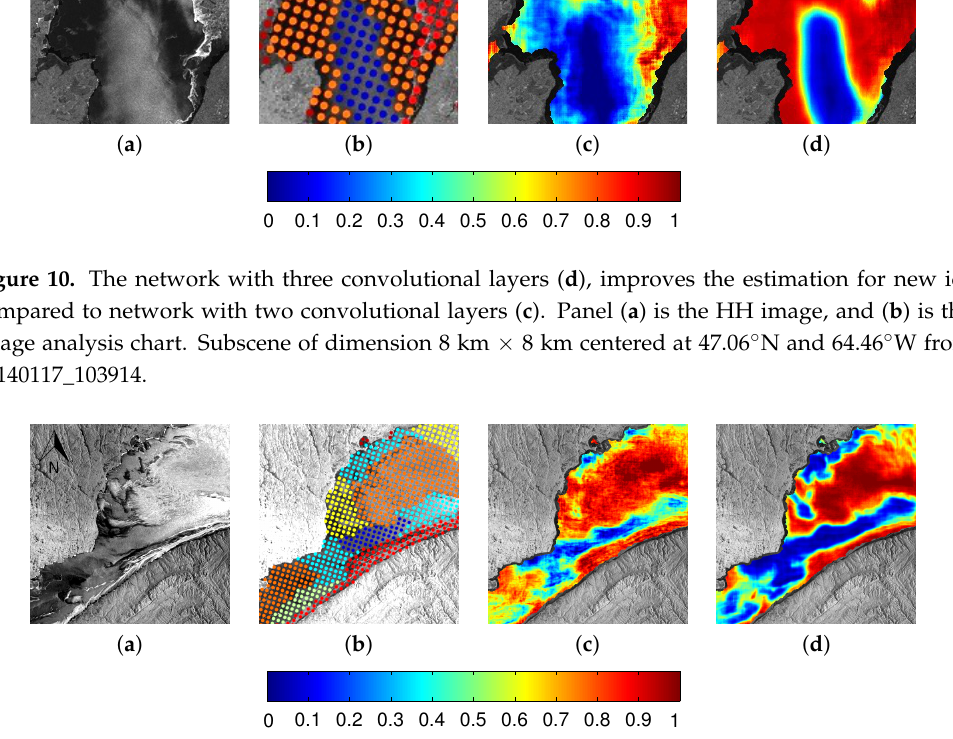
Figure 11. Comparison of results produced by networks with two-convolutional-layer ( c ) and three-convolutional-layer structures ( d ) for a sample location centered at 49.57 ◦ N, 66.59 ◦ W with size 200 km × 200 km in scene 20140127_104734 in Gulf of Saint Lawrence. Estimate by the two-convolutional-layer network is noisier. The three-convolutional-layer network produces smoother and more reasonable results. Panel ( a ) is the HH image and ( b ) is the image analysis chart for the